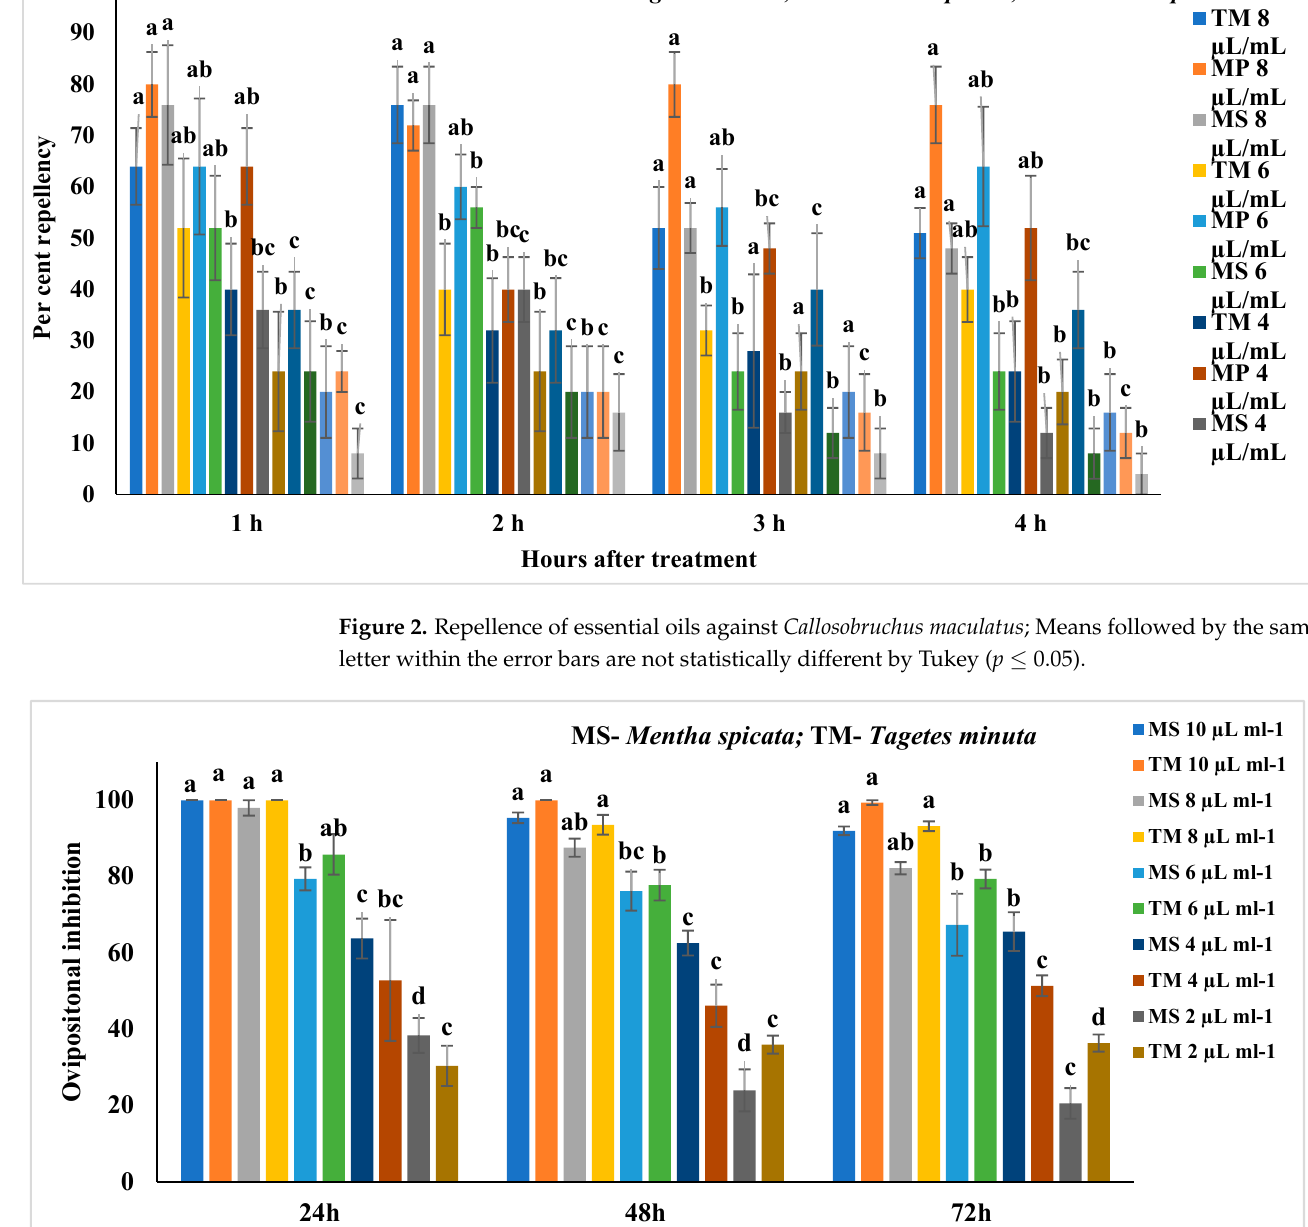
Figure 4. Ovipositional inhibition of Mentha piperita against Callosobruchus chinensis ; Means followed by the same letter within the error bars are not statistically different by Tukey ( p ≤ 0.05). 2.5.2. Callosobruchus maculatus The ovipositional deterrent activity of EOs against C. maculatus was present in the Supplementary Table S7 and Figure 5. M. piperita significantly affected the oviposition by